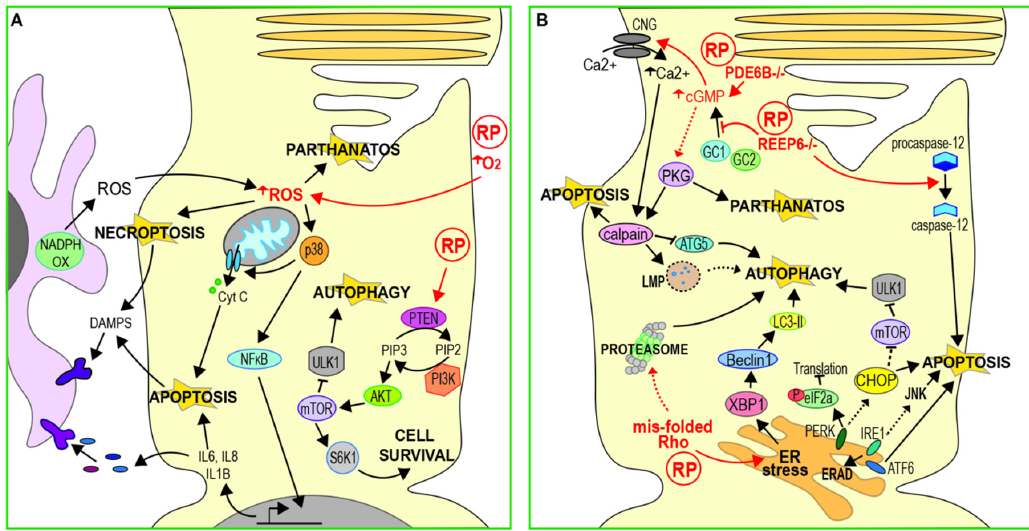
Figure 2. Pathways leading to rod photoreceptor death in RP. ( A ) Oxidative stress caused by increased extracellular O 2 or extracellular ROS produced by activated microglia can induce apoptosis via the p38 / NFkB pathway. Increased intracellular ROS may also trigger necroptosis or parthanatos. The mTOR pathway may be inhibited in RP through increased PTEN activity, this down-regulates cell survival pathways and increases autophagy. DAMPS released by apoptotic or necroptotic cells cause further activation of microglia. ( B ) Raised cGMP levels lead to increased Ca 2+ influx, resulting in calpain activation and death by apoptosis. ER stress resulting from raised Ca 2+ or accumulation of mis-folded rhodopsin activates PERK, Ire1 and ATF6. While this can lead to protective responses such as translation inhibition or ERAD, sustained ER stress can also trigger apoptosis. ER stress can also lead to increased autophagy and this, in turn, can lead to the degradation of proteasome subunits. Reducing autophagy allows more mis-folded rhodopsin to be degraded by the proteasome, thus reducing ER stress. Calpain activation can inhibit autophagy through lysosomal membrane permeablisation (LMP) and the cleavage of autophagy proteins such as ATG5. (ROS = reactive oxygen species; NFkB = necrosis factor k B; mTOR = mammalian target of rapamycin; ERAD = endoplasmic-reticulum-associated protein degradation; DAMP = damage-associated molecular patterns; PTEN = phosphatase and tensin homolog; PERK = protein kinase RNA-like endoplasmic reticulum